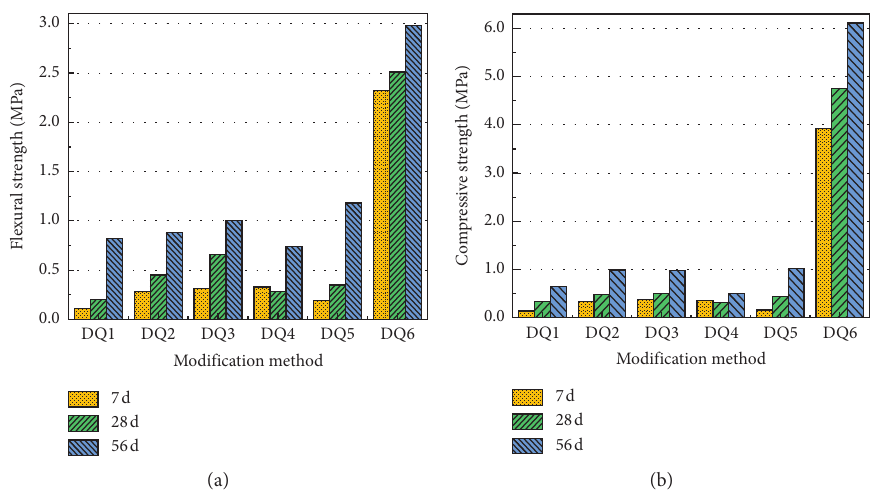
Figure 7: Strength of SFCC: (a) flexural strength; (b) compressive